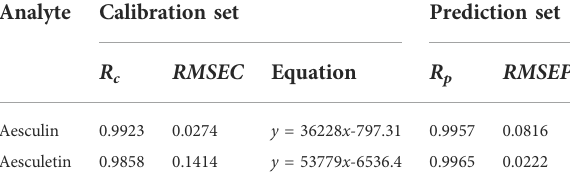
TABLE 3 Analytical results related to the calibration and prediction results for aesculin and aesculetin based on the UPLC method. Analyte Calibration set Prediction